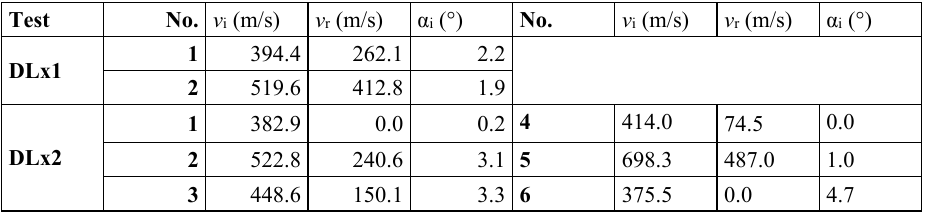
Table 1. Overview of the ballistic impact